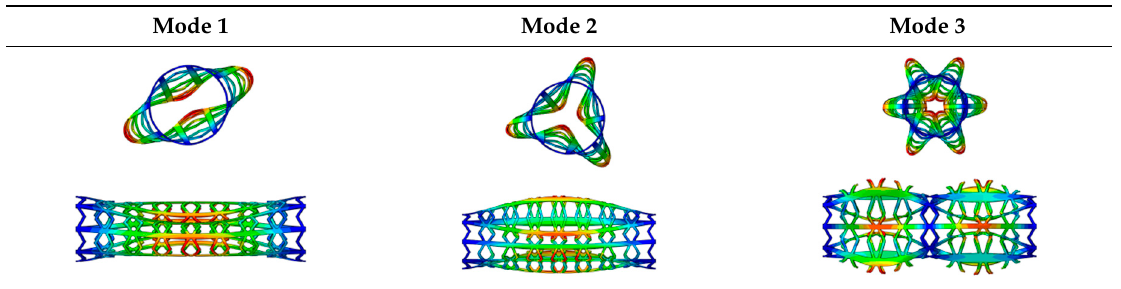
Figure 4. First three orders buckling eigenvalues of SMP stent with different numbers in circumferential direction: Nc = 8/12/16. 4.1.2. Nonlinear Buckling Analysis Actually, the large deformation of structure during buckling often induces nonlinearity and thus the linear analysis is conservative. Here, we further conducted the nonlinear analysis of the SMP stents for N C = 8/12/16 using Riks’ method. The load is considered with 1 MPa. Figure 5 illustrates the buckling performance of the stent with Nc = 8. The curve shows a turning point approximately at the load proportionality factor (LPF) of 0.02, where the structure first buckles. The critical load is 1 × 0.02 = 0.02 MPa. The nonlinear analysis yields a smaller critical buckling load compared to that of the linear analysis, due to the nonlinear deformation and material nonlinearity of the SMP stent. Table 4 shows the static buckling load comparison for different values of radii (or different values of Nc ). The results confirm that a stent with a larger radius buckles more easily. Figure 5. LPF curve of SMP stent.